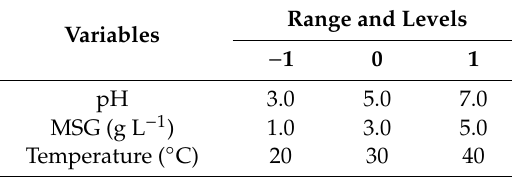
Table 1. The selected variables, range and levels inputted for optimisation study.